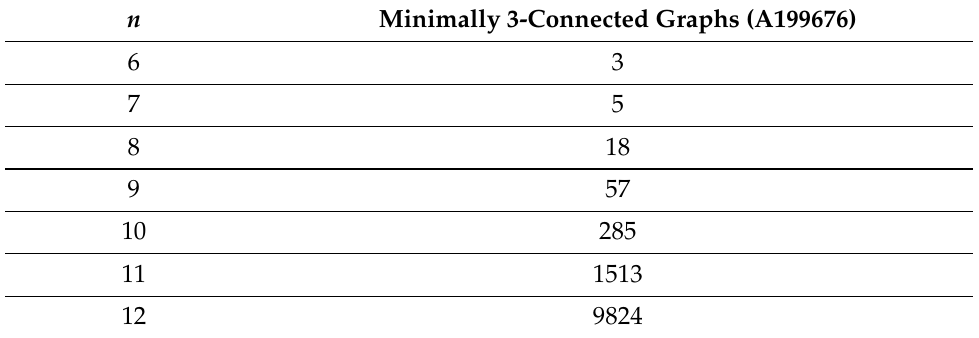
Table 1. 3-connected graphs and minimally 3-connected graphs graphs from